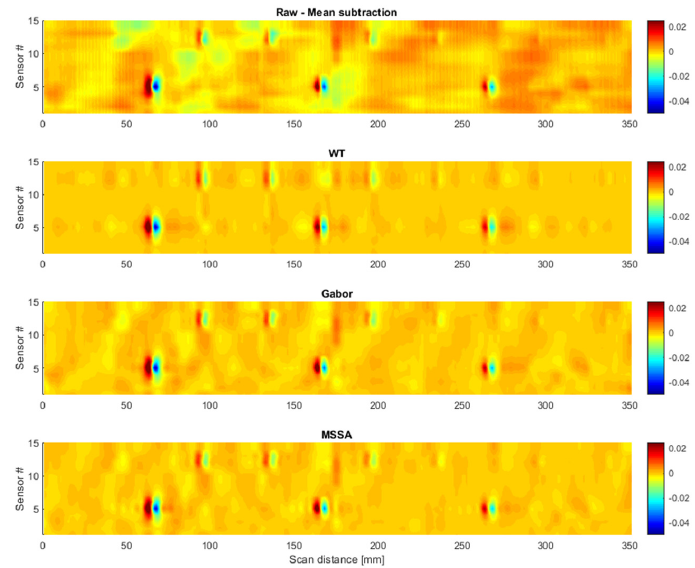
Figure 11. Magnetic scanned signal by the PSECT method with the wavelet, Gabor and proposed MSSA filters.